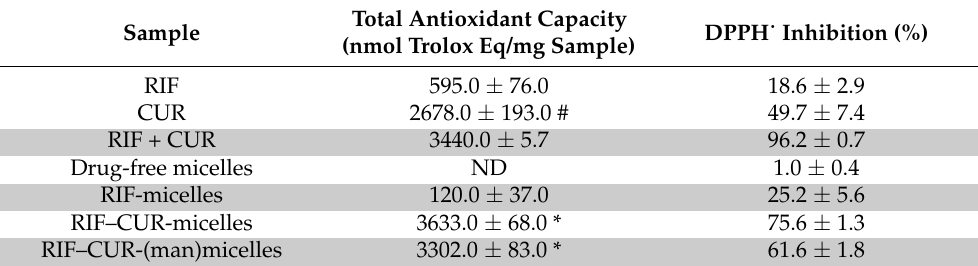
Table 6. Antioxidant activity of nanoformulations (drug-free, RIF-micelles, RIF–CUR-micelles and RIF–CUR-(man)micelles) and drugs solutions (CUR, RIF and RIF + CUR), calculated as the inhibition percentage of DDPH radical. Data are expressed as mean ± S.D. (n = 6).